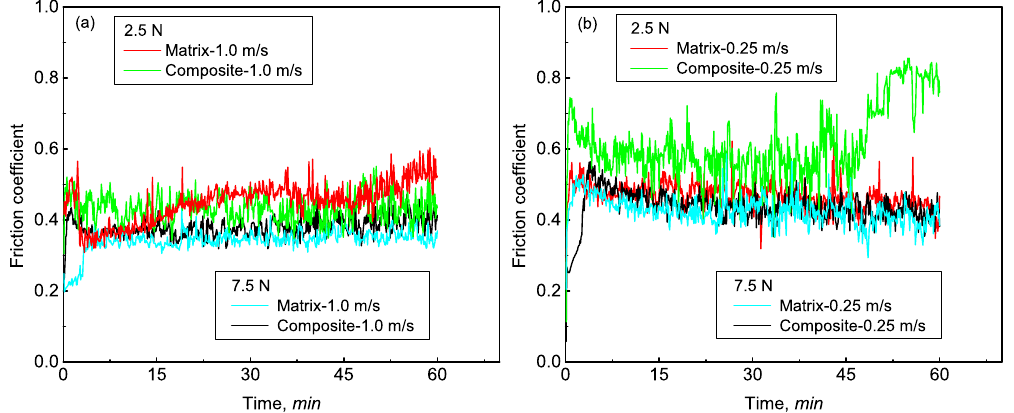
Figure 4. Typical friction-coefficient curves vs. testing time of the Al–12Si–CuNiMg matrix alloy and the Al 2 O 3 fiber-reinforced composite corresponding to applied loads of 2.5 and 7.5 N under sliding velocities of ( a ) 1.0 m/s and ( b ) 0.25